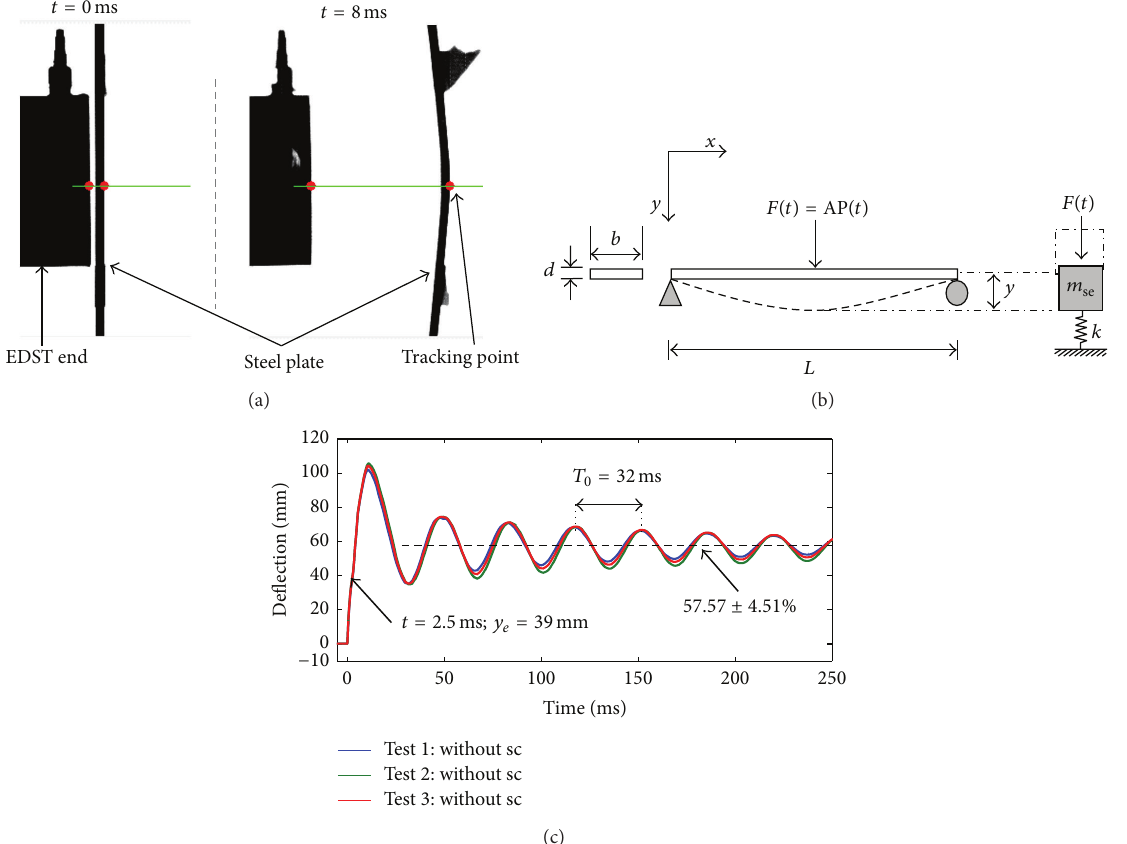
Figure 7: (a) Labview code used to track the middle point of the simply supported beam based on the video recorded by HSC1, (b) the equivalent SDOF system, and (c) the midspan response of a simply supported beam under a localized blast load for three tests.